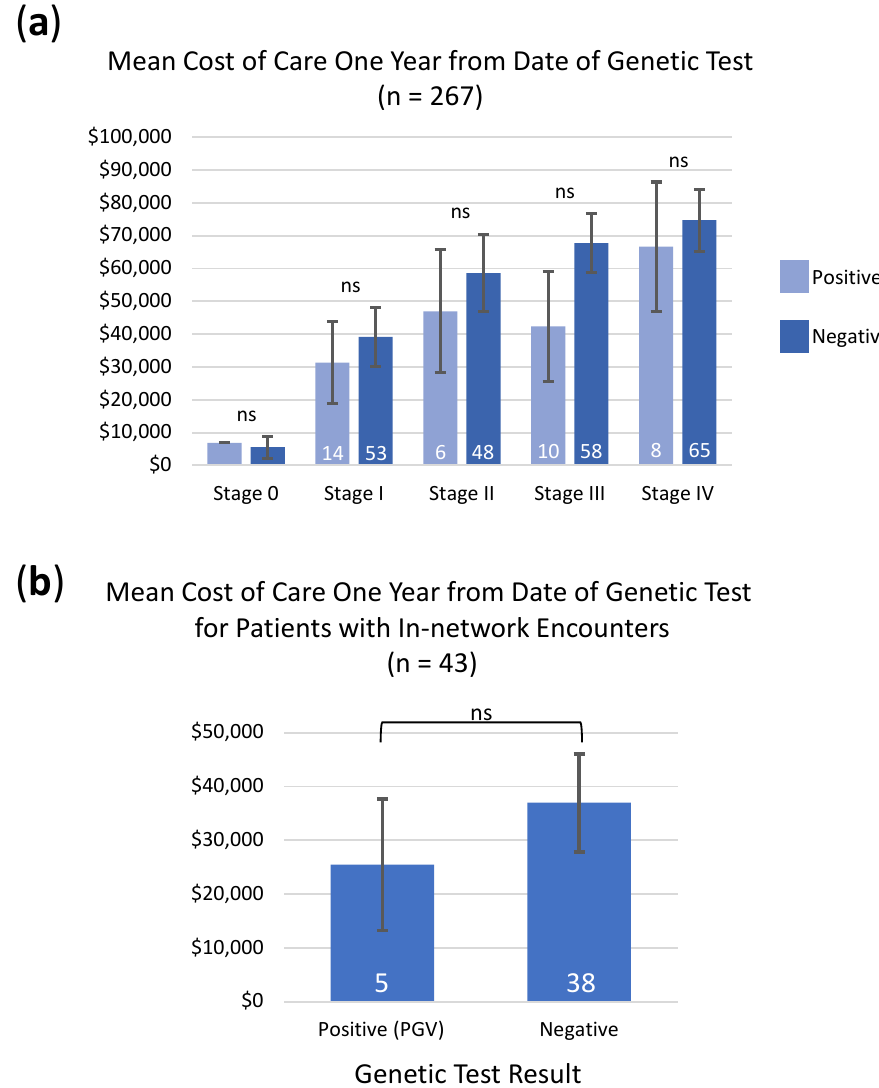
Figure 3. Mean cost of care within one year from the date patients received genetic testing. ( a ) Data from patients with one year follow-up broken down by stage at diagnosis. Stage 0 positive n = 1; stage 0 negative n = 4. ( b ) Data for in-network encounters. Error bars represent standard error. p -values based on student’s t-test. n.s = not significant. N-values indicated within each